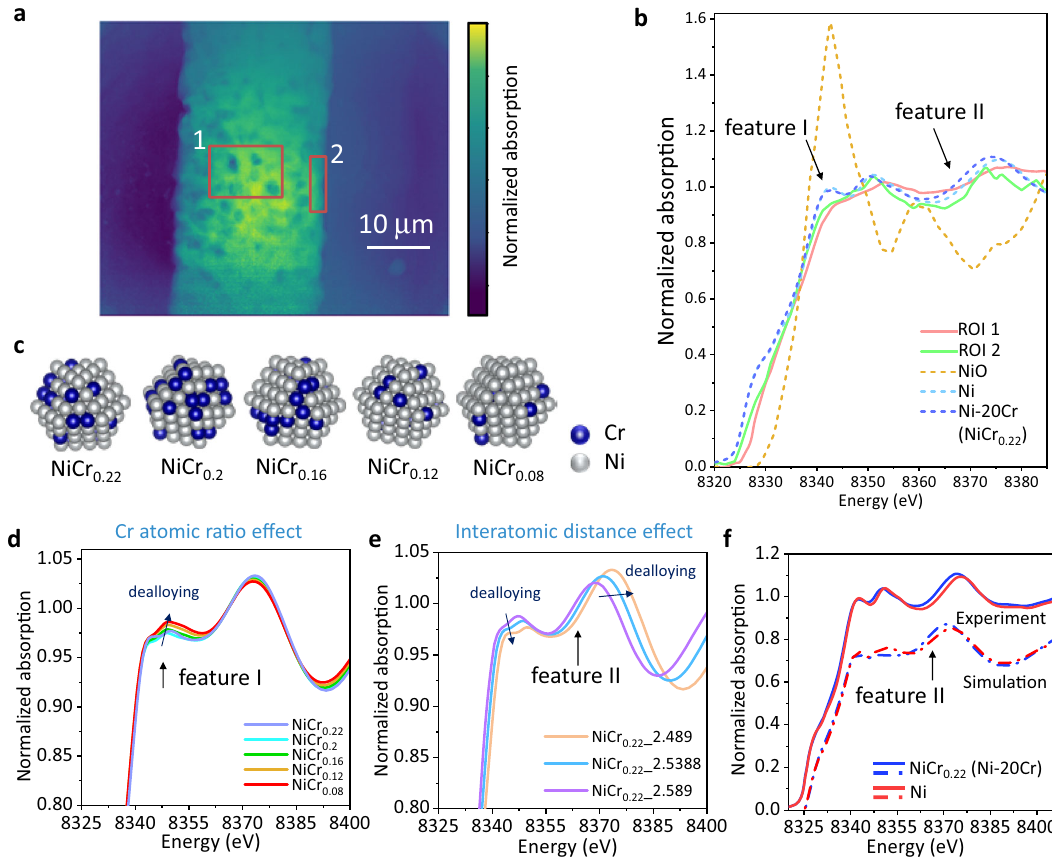
Fig. 3 XANES spectroscopic imaging and modeling of Ni – 20Cr dealloying. a A representative frame from the 2D XANES spectroscopic mapping; two regions of interests (ROIs) were selected from the porous wire. b Normalized Ni K-edge XANES spectra of pristine Ni – 20Cr, porous wire after 192.1 min heating at 800 °C [both ROIs as marked in a ], and the standards (Ni and NiO). c Structural representations of six models with different Ni to Cr atomic ratios (78:22, 80:20, 84:16, 88:12, 92:8, and 100:0) and a constant Ni – M (Ni or Cr) distance (2.489 Å). d Simulated XANES spectra of the six models with different Ni-to-Cr atomic ratios. e Theoretical XANES of the three NiCr 0.22 (Ni – 20Cr) models with different Ni – M (Ni or Cr) distances (2.4890, 2.5388, and 2.5890 Å). When the distance decreased (corresponding to dealloying), the feature at ~8370 eV (feature II) slightly shifted to the higher energy, consistent with the similar shift in the experiment. f The XANES spectra comparison between simulated and experimental results of Ni and Ni – 20Cr (NiCr 0.22 ). The changes in the XANES spectra in b , d – f are shown as feature I and feature